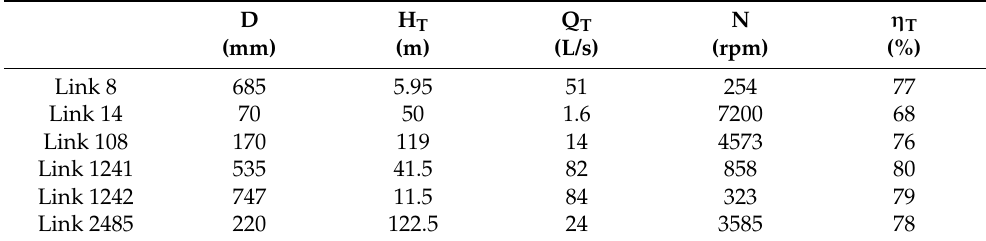
Table 4. Turbine geometry resulting from case (II).